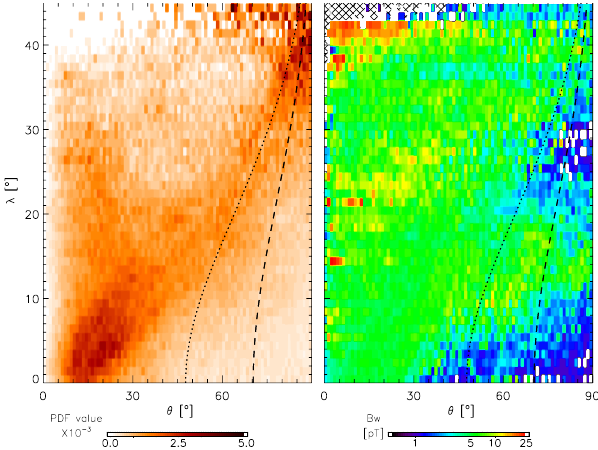
Fig. 1. Distribution of lower-band chorus occurrences in the θ – λ space (left panel) and wave amplitude distribution (right panel) shown for the day sector and 4 < L < 5 in the moderate to medium geomagnetic activity range Kp < 3 (shaded regions indicate insuf- ficient statistics). Black curves show Gendrin and resonance cone angles for 3kHz at L = 4 .